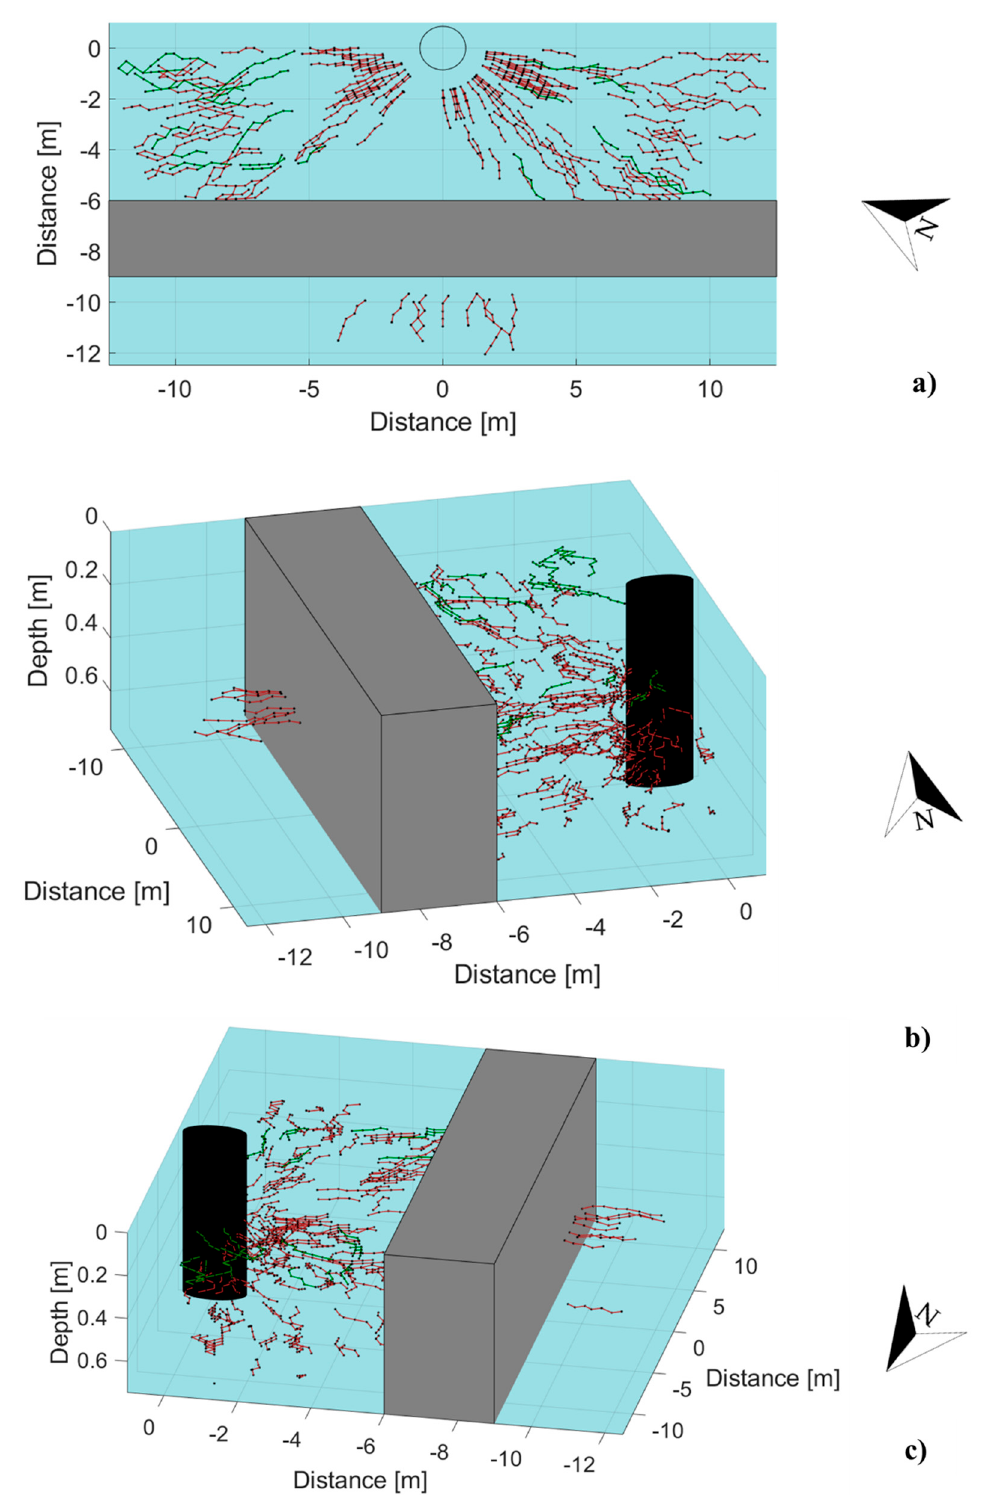
Figure 12. Reconstructed map of the tree root system architecture: ( a ) 2D planar view, ( b ) 3D view from South-West, and ( c ) in a 3D view from North-West. The grey block represents the volume occupied by the buried feature.